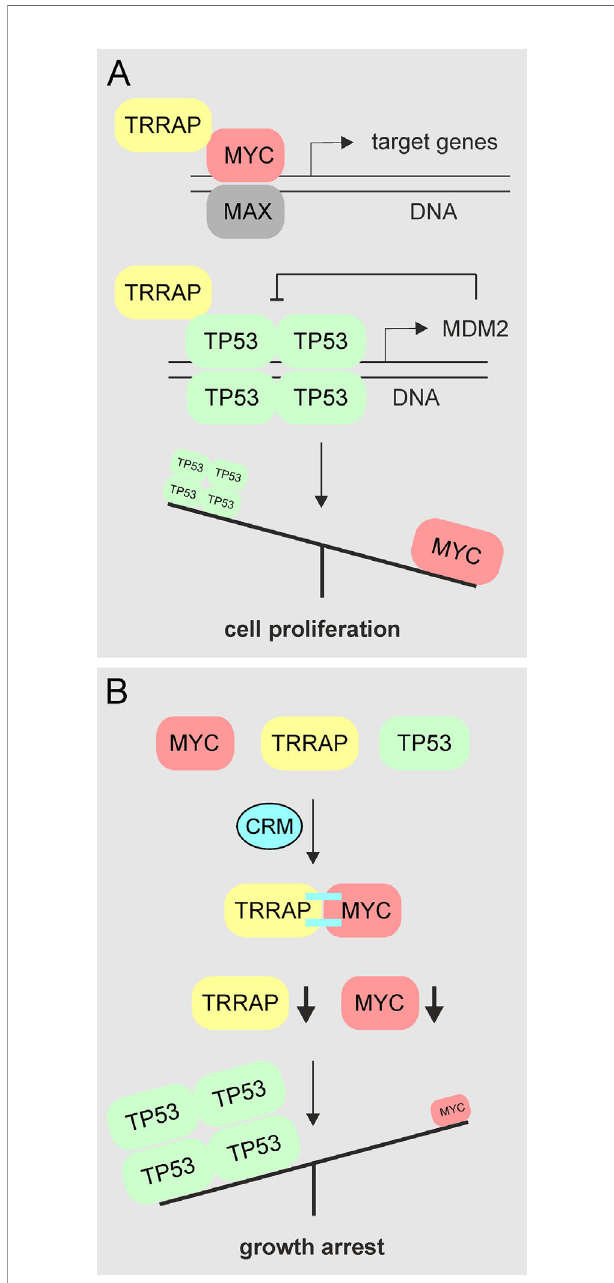
FIGURE 7 | Schematic diagram showing the proposed mechanism of MYC inhibition by curcumin. (A) In proliferating cells or in cells containing aberrantly activated MYC, this transcription factor binds to DNA in complex with the MAX protein and regulates or deregulates the expression of multiple target genes required for cell proliferation or cell transformation. For this activity interaction with other transcriptions factors or coactivators such as TRRAP is required. Likewise, TRRAP also binds to the tumor suppressor TP53 forming functionally active tetramers (64), thereby inducing transcription of the MDM2 gene, whose protein product then negatively regulates TP53. (B) In the presence of curcumin, MYC becomes covalently cross-linked (=) to TRRAP. Thereby, endogenous MYC and TRRAP levels are reduced, whereas TP53 levels remain unchanged mediating the observed growth